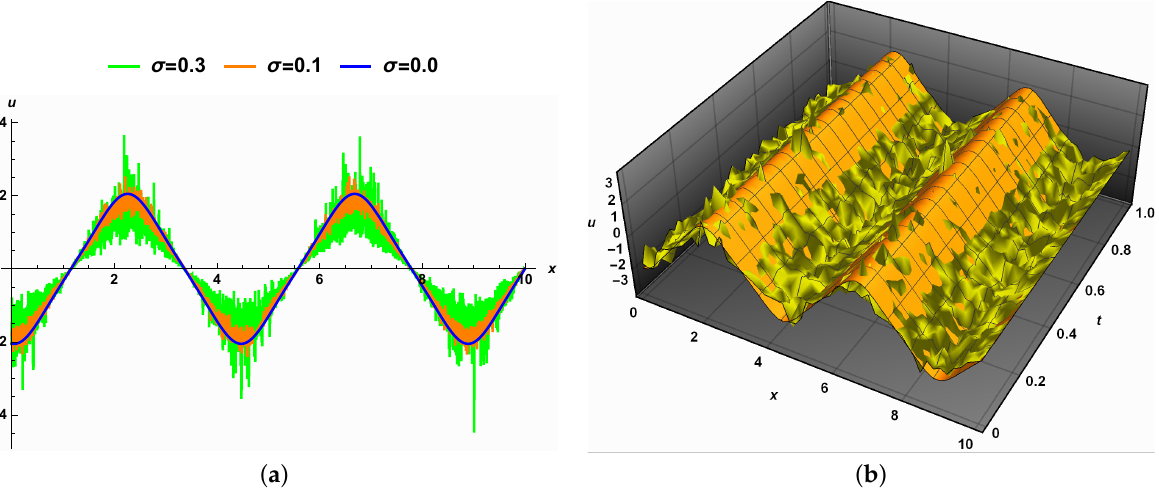
Figure 3. The effect of the noise on the solution (19) when α → 1.